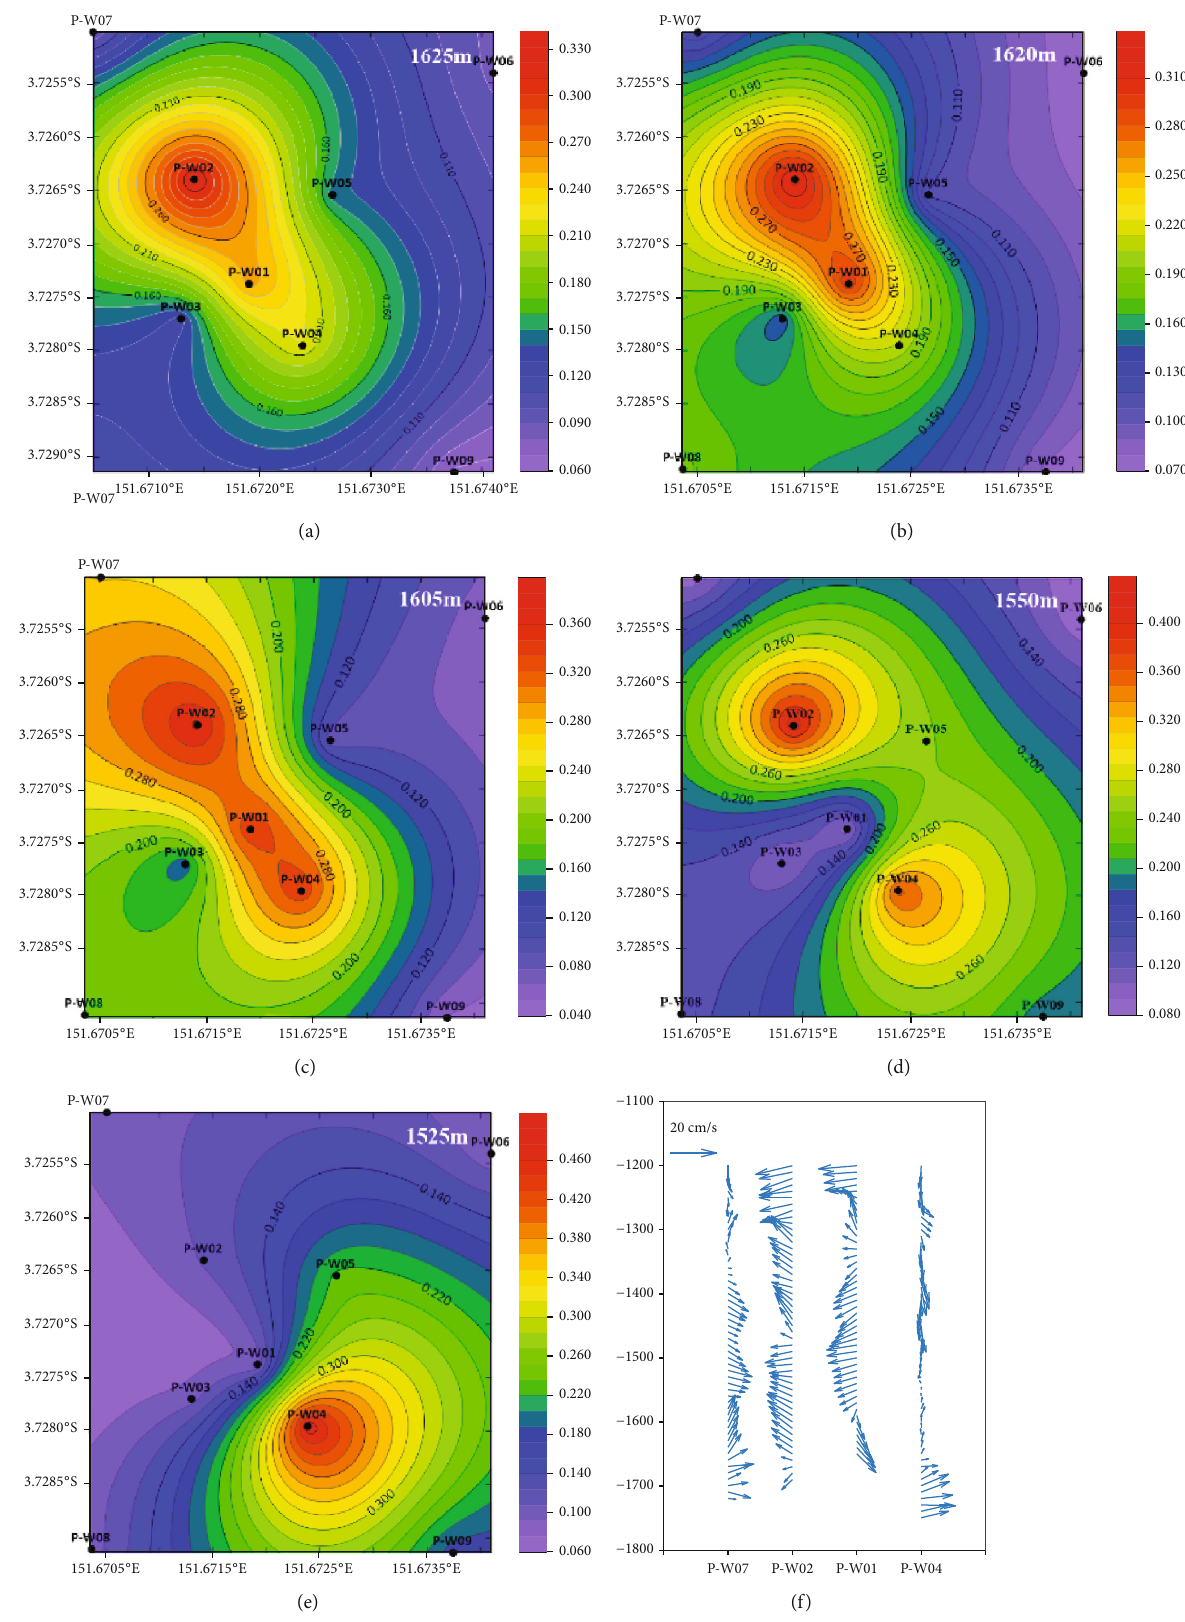
Figure 4: Turbidity contour and current velocity map of the PACMANUS hydrothermal fi